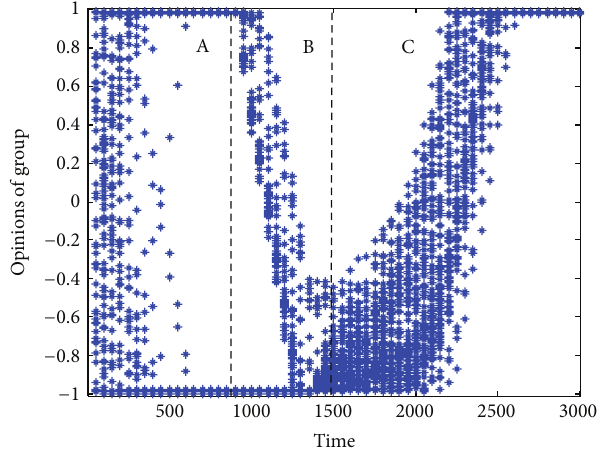
Figure 17: Group opinions change with time. Areas A, B, and C correspond to the three stages of the evolution process of group opinions by adjusting the parameters of 𝑎 , 𝑏 , 𝑐 , and 𝐼 𝑜 . The parameters in area A are 𝑎 = 1 , 𝑏 = 0 , and 𝑐 = 0 ; in area B they are 𝑎 = 0.8 , 𝑏 = 0.2 , and 𝑐 = 0 ; in area C they are 𝑎 = 0.6 , 𝑏 = 0.2 , = 0.1 𝑐 = 0.2 , and 𝐼 𝑜